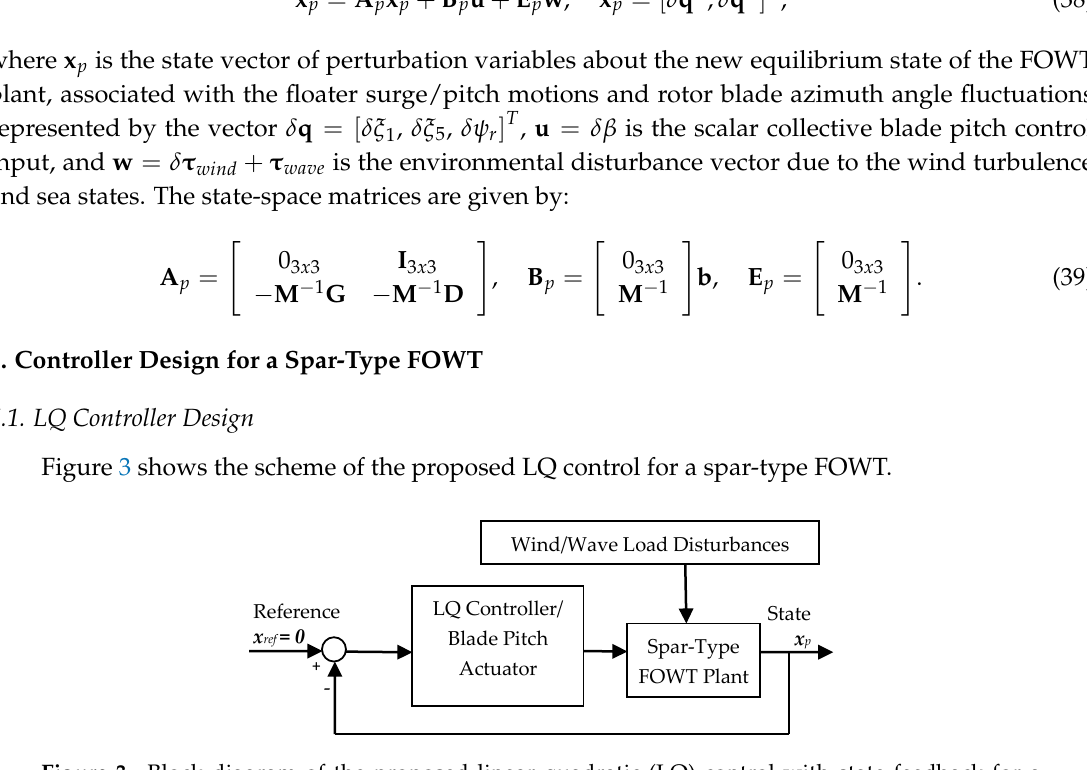
Figure 3. Block diagram of the proposed linear quadratic (LQ) control with state feedback for a spar-type FOWT.